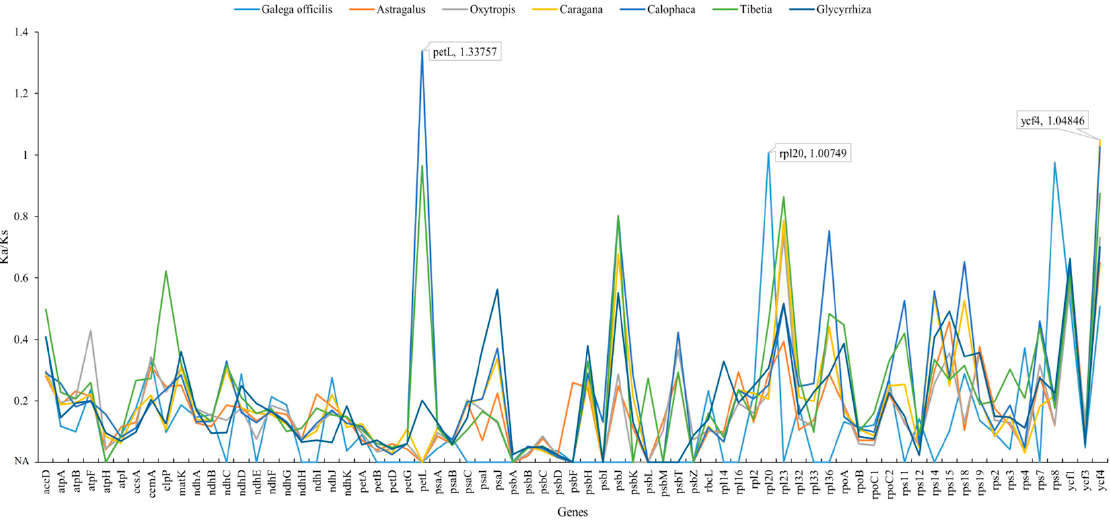
Figure 5. The Ka/Ks values of 71 shared genes between G. orientalis and other Galegeae species. The Ka/Ks values between G. orientalis and each genus are the average values of the Ka/Ks between G. orientalis and the species within the genus.